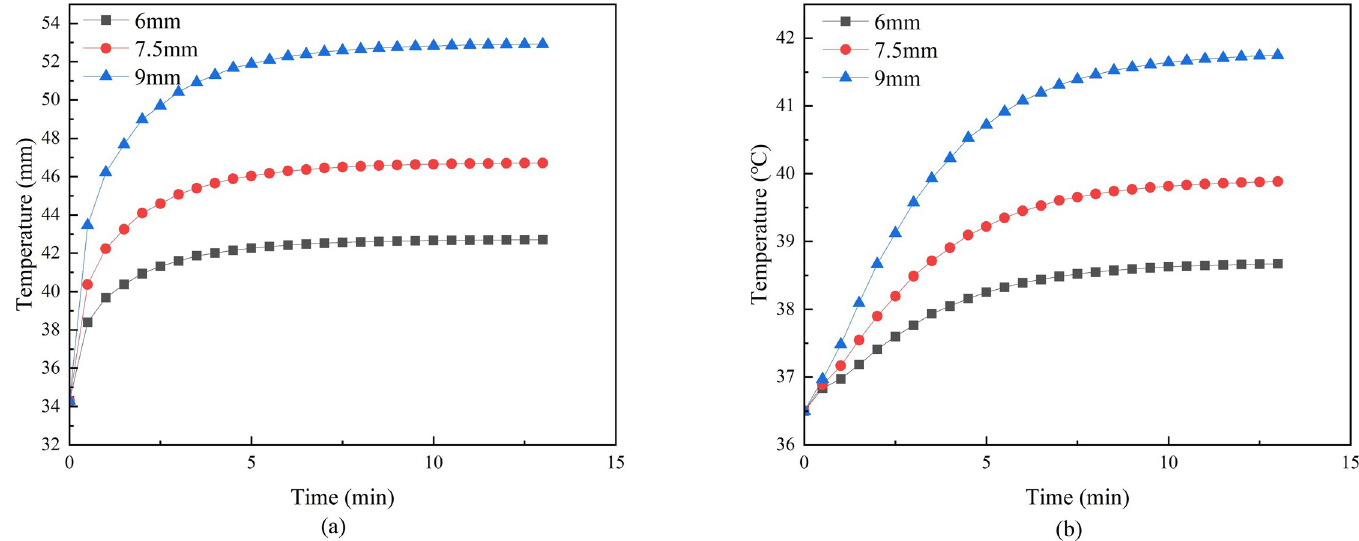
Fig 7. (a) Temperature curve at moxibustion point with different moxa radius. (b) Temperature curve at 5mm under moxibustion point with different moxa radius.